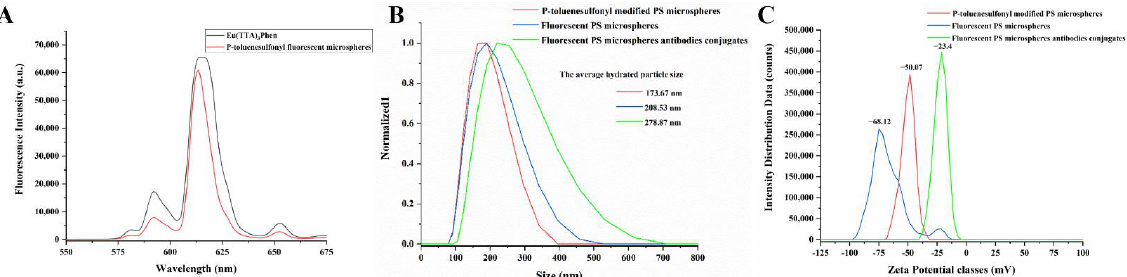
Figure 5. Physical and optical properties of fluorescent PS microspheres. ( A ) Fluorescence emission spectra of Eu(TTA) 3 Phen and fluorescent PS microspheres excited by 365 nm UV light. ( B ) Changes in the hydrated particle size of PS microspheres during the reaction. ( C ) Variation of Zeta potential on the surface of PS microspheres during the reaction.